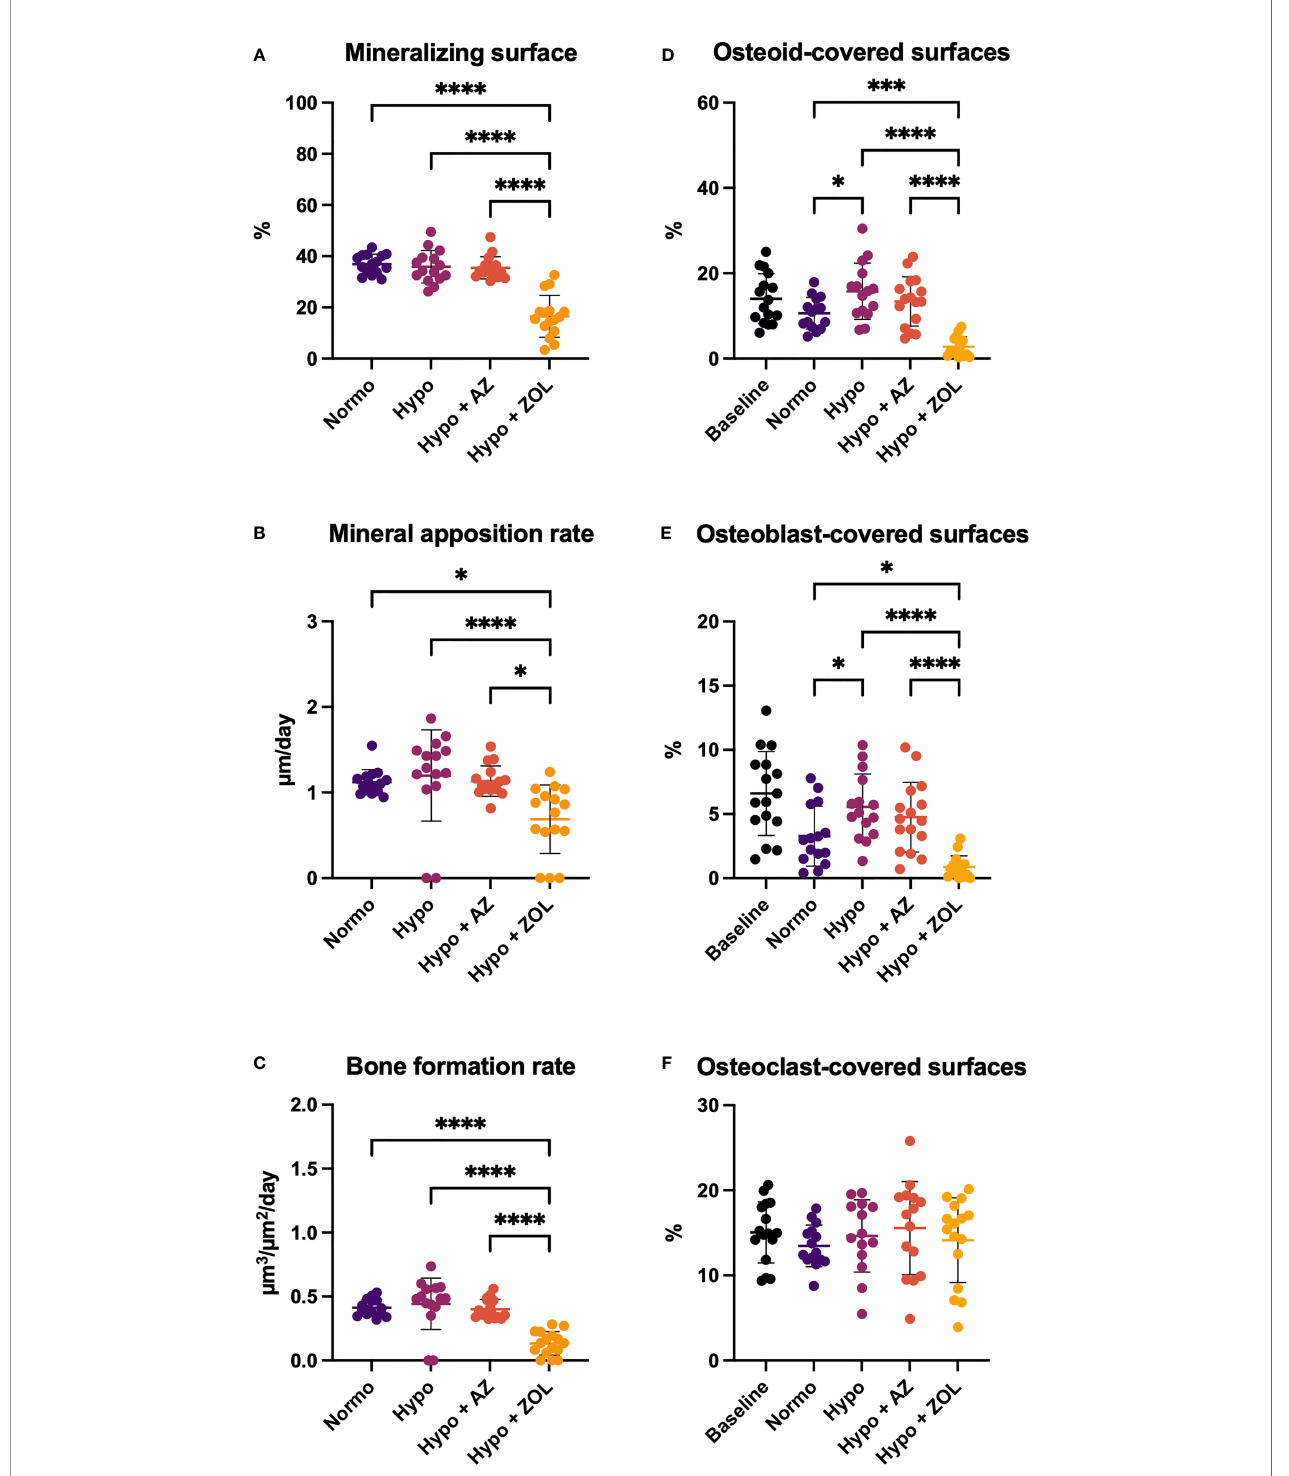
FIGURE 5 | Distal femoral trabecular bone parameters determined by dynamic bone histomorphometry (A – C) and osteoid (D) and bone cells quanti fi cation (E, F) of mice housed at normobaric ambient pressure (Normo) or hypobaric pressure (Hypo) at 500 mbar for four weeks and treated with acetazolamide (AZ) or zoledronate (ZOL). All data were analyzed using a one-way ANOVA, except for mineralizing surface and mineral apposition rate where the non-parametric Kruskal – Wallis test were used. Data are presented as mean ± SD and n = 15 – 16/group. *p < 0.05, ***p < 0.001, and ****p <